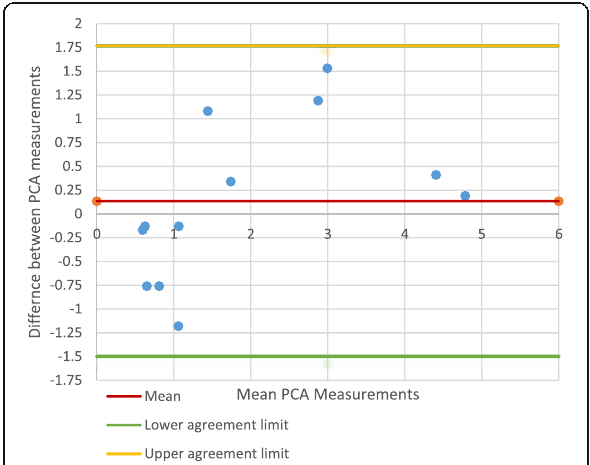
Fig. 7 PCA Measurements on CT: anatomical vs . mechanical axis (Best fit technique)